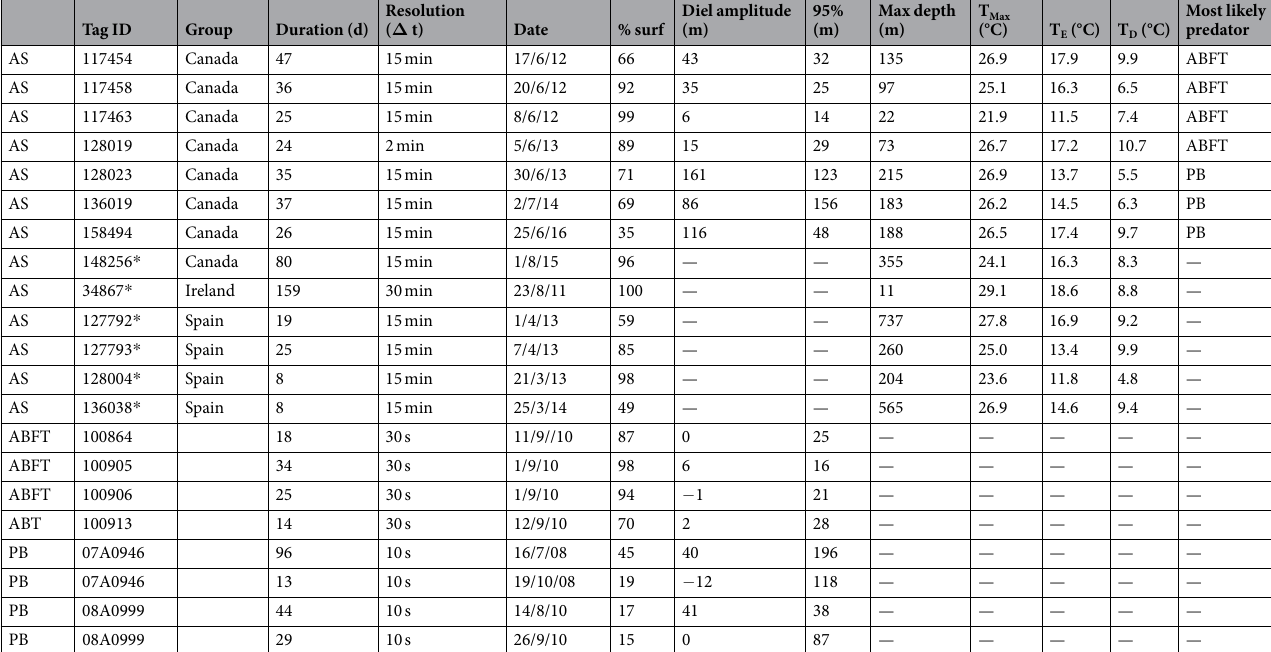
Table 3. Data obtained from the tagged Atlantic salmon (AS) consumed by endothermic fish and data from the endothermic fish predators used in the linear discriminant analysis (ABFT = Atlantic bluefin tuna, PB = porbeagle). Atlantic salmon denoted with an asterisk ( * ) were not included in the linear discriminant analysis. Duration indicates the time from release till predation for the Atlantic salmon (AS) and the length of the time series for the predators (ABFT and PB). Resolution indicates the temporal resolution of the tag data. Date indicates the time of predation for the Atlantic salmon (AS) and start of time series for the predators (ABFT and PB). %Surf is the proportion of time spent near the surface ( < 20 m), diel amplitude is the difference in maximum depth between day and night, and 95% is the 95 th percentile of all recorded depths. T Max is the maximum stomach temperature of the predator, T E is the thermal excess, and T D is the maximum difference in stomach